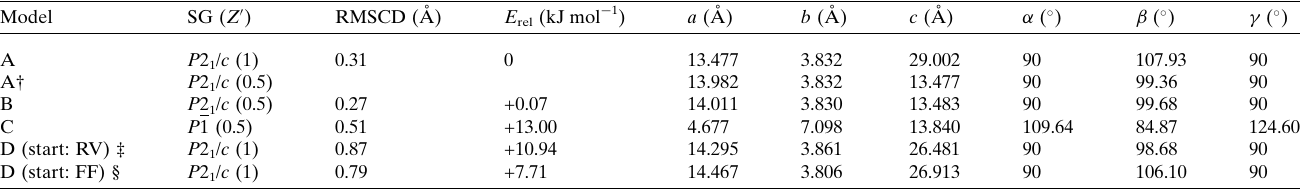
Table 8 Results of the DFT-D optimizations of the four structural models with GRACE , including optimization of the lattice parameters. RMSCD is the root mean-square Cartesian deviation of the non-hydrogen atoms between the structure from Rietveld refinement and from DFT-D optimization. E rel denotes the lattice energy (per molecule) relative to model A. Models A and B are identical, except for a different unit-cell setting Model